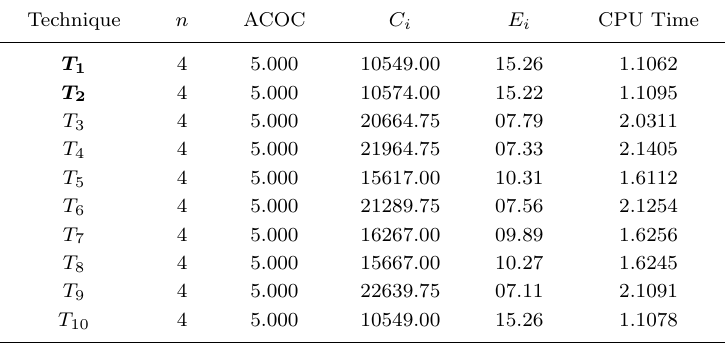
Table 4. Comparison of performance of techniques for Problem 3.